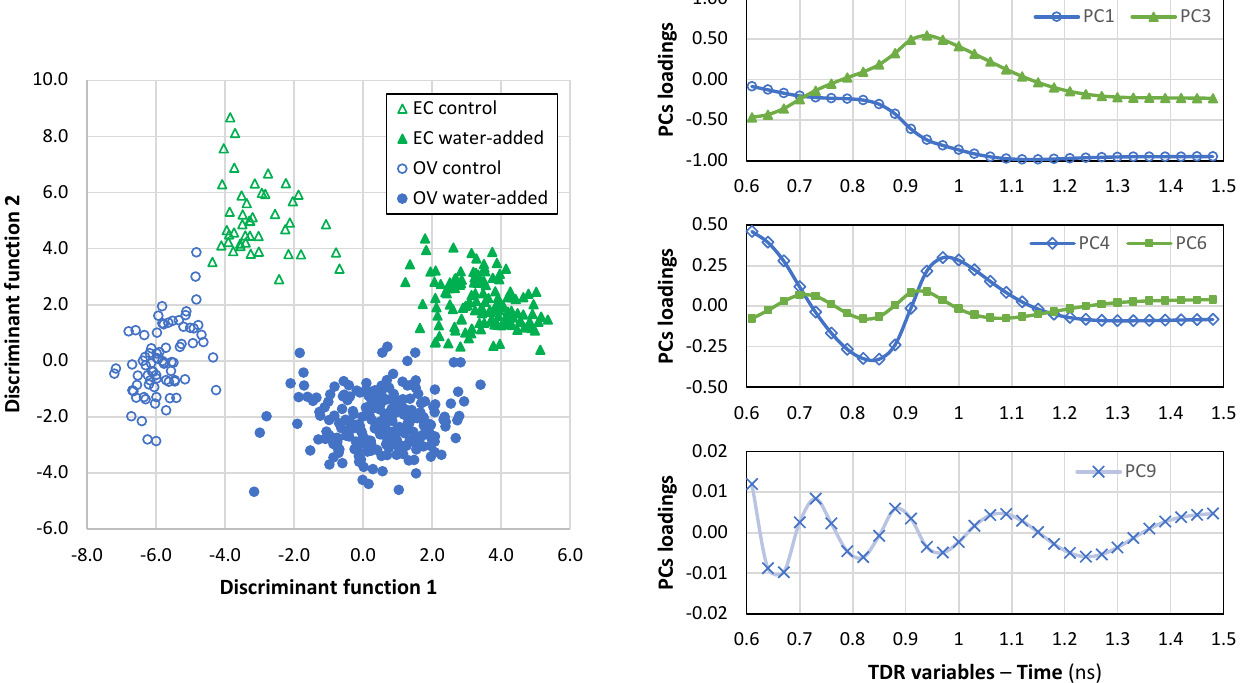
Figure 6. Plot of the discriminant analysis model of TDR data of Octopus vulgaris (OV) and Eledone cirrhosa (EC) samples and loadings of PCs with the highest factor structure coefficients. The immersion time of water-added treatments varied between 0.5 and 36 h. The discriminant analysis was performed using the principal components obtained from the TDR data, and the plot shows the scores of discriminant functions 1 and 2. The explained variance accounted for was 61.4 and 37.3% by discriminant functions 1 and 2, respectively. Table 2. Classification results (number of samples and percentage) of discriminant analysis of TDR data of Octopus vulgaris and Eledone cirrhosa samples. The immersion time of water-added treatments varied between 0.5 and 36 h. The discriminant analysis was performed in the principal components obtained from the TDR data (between 0.6 and 1.5 ns). The same a priori classification probability was chosen for all groups. Correct classifications are shown in bold. In model 1, 98.8% of samples (used for training) were correctly classified. In model 2, all samples used for training and 87.5% of samples used for testing were correctly classified. In the cross validation, 98.6% of samples were correctly classified.